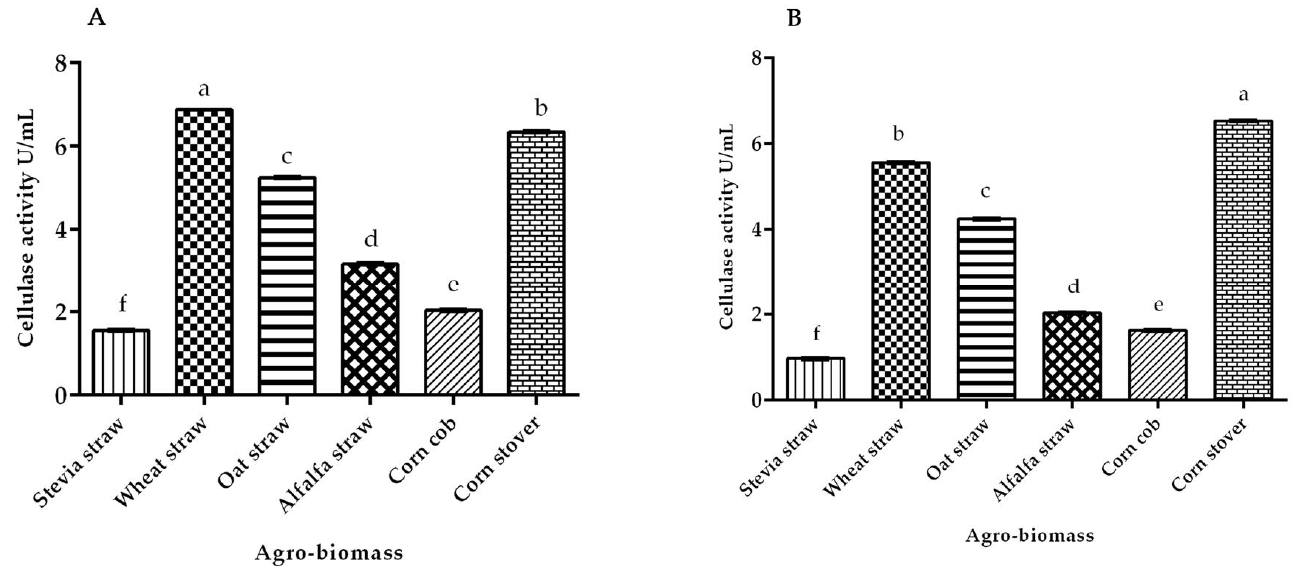
Figure 3. ( A ) Cellulase activity of white rot fungus P . ostreatus under submerged fermentation on different agro-biomass. Bars with different letters (a–f) are significantly different at p < 0.05. ( B ) Cellulase activity of white rot fungus P . chrysosporium under submerged fermentation on different agro-biomass inducers. Bars with different letters (a–f) are significantly different at p < 0.05.